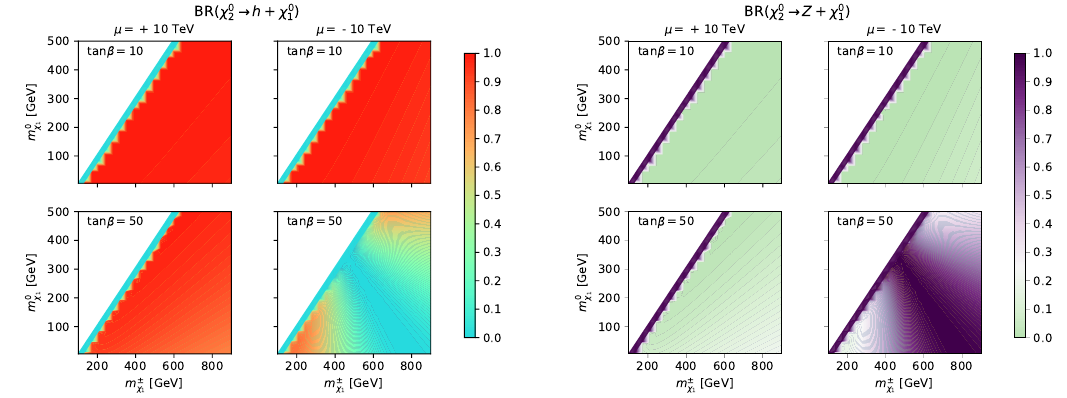
Figure 3 . Left: branching ratio of χ 0 5 & 10 , presented in the m the same parameters.